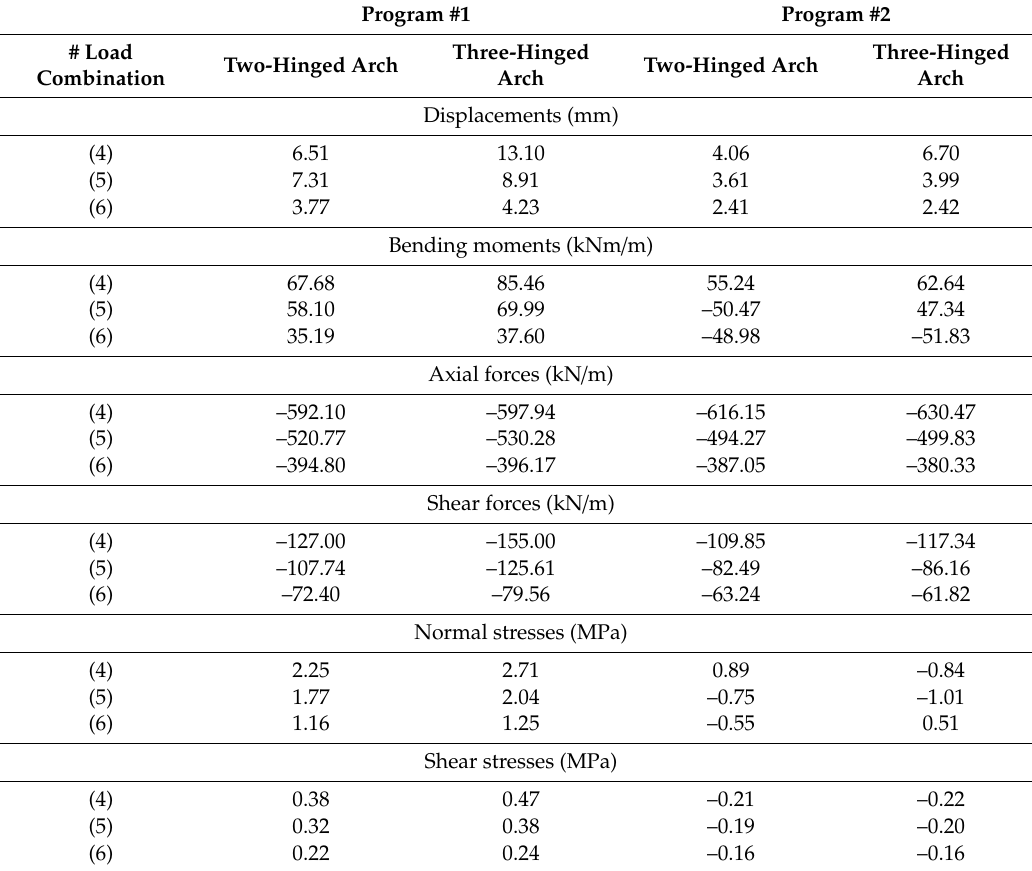
Table 4. Juxtaposition of maximum internal forces in the masonry viaduct (three- and two-hinged arch) for the applied load